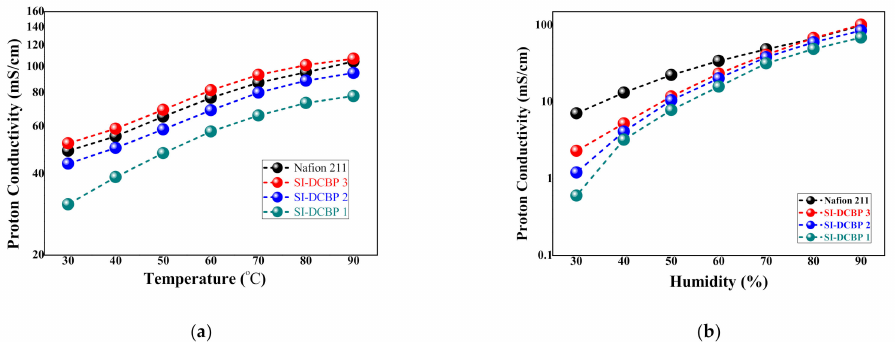
Figure 4. Proton conductivity for the SI-PBP polymer membranes in ( a ) different temperatures at 90% RH ( b ) different relative humidity at 90 ◦ C.